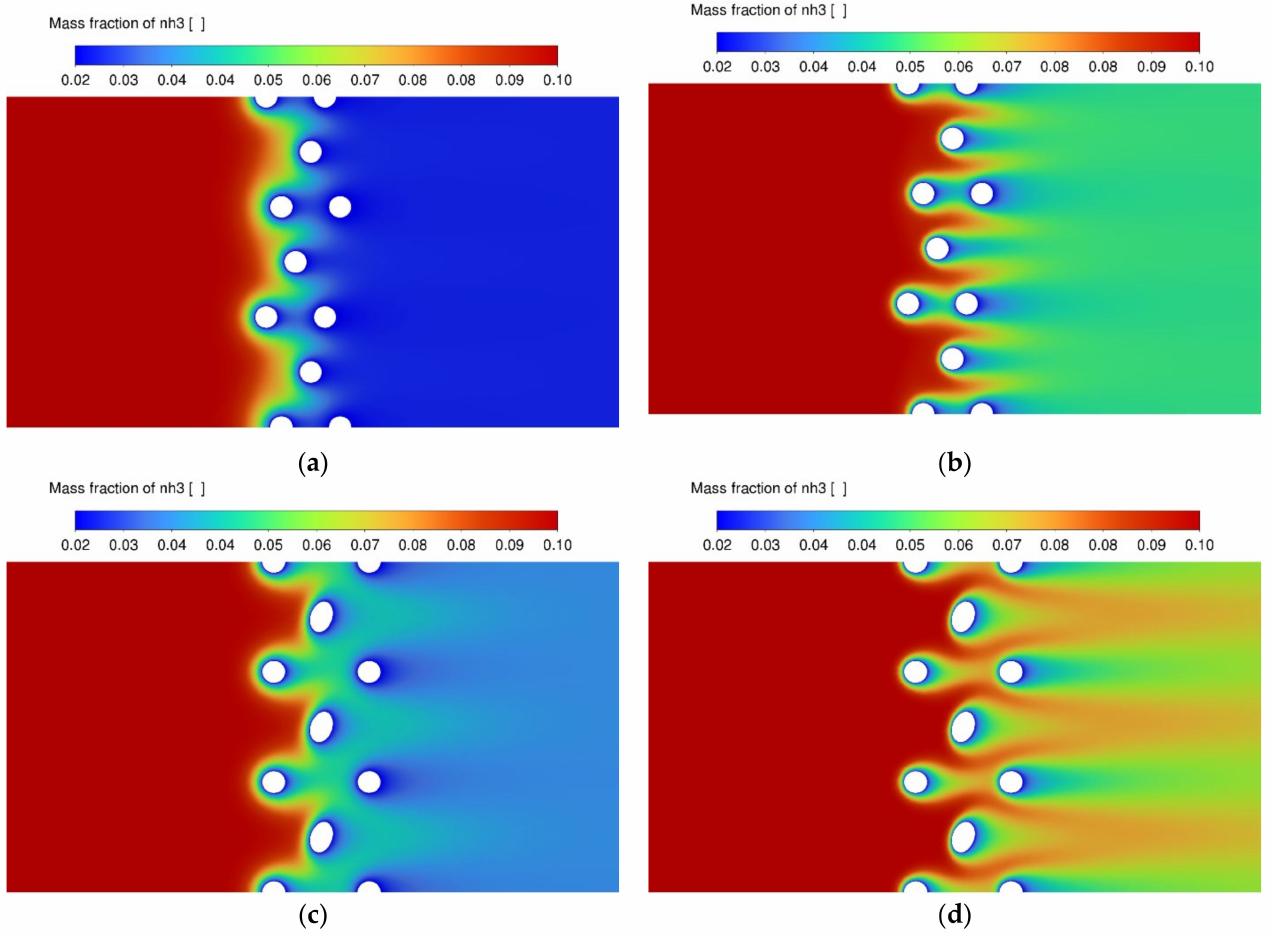
Figure 8. NH 3 mass fraction contours for: ( a ) Geometry A, contact time of 0.001 s; ( b ) Geometry A, contact time of 0.00025 s; ( c ) Geometry B, contact time of 0.001 s; ( d ) Geometry B, contact time of 0.00025